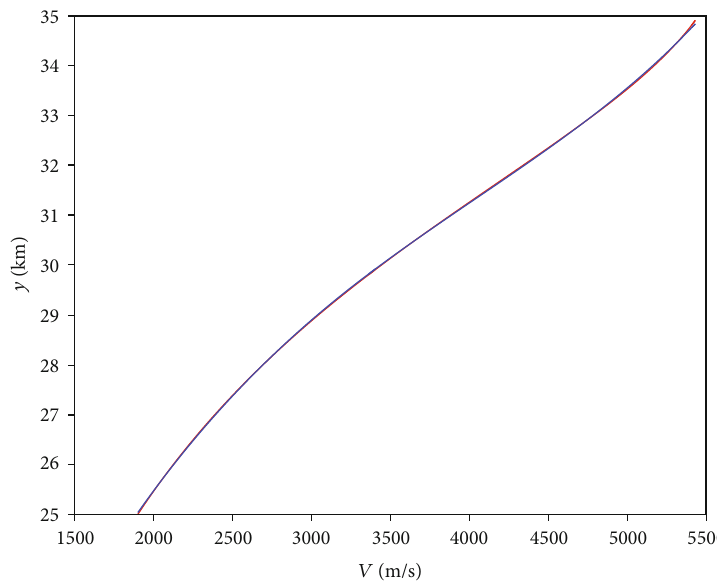
Figure 10: Quasiequilibrium glide altitude pro fi le with respect to velocity.